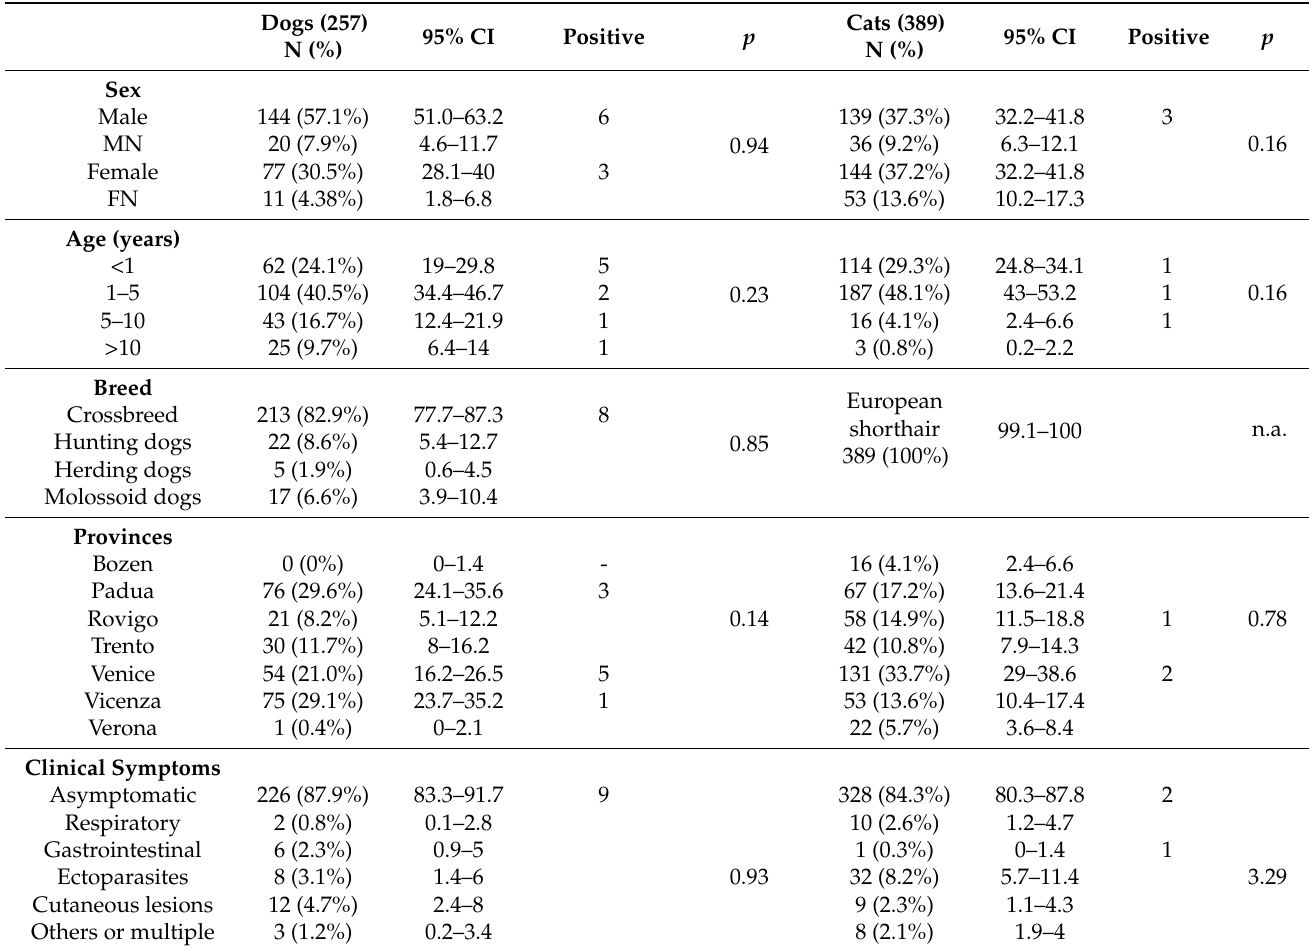
Table 1. Demographic information and serological results of the enrolled animals. Prevalence and 95%CI (confidential intervals). The statistical relevance and inter-parametric evaluation were performed with Pearson’s X 2 test ( p -values). Number of missing information are not